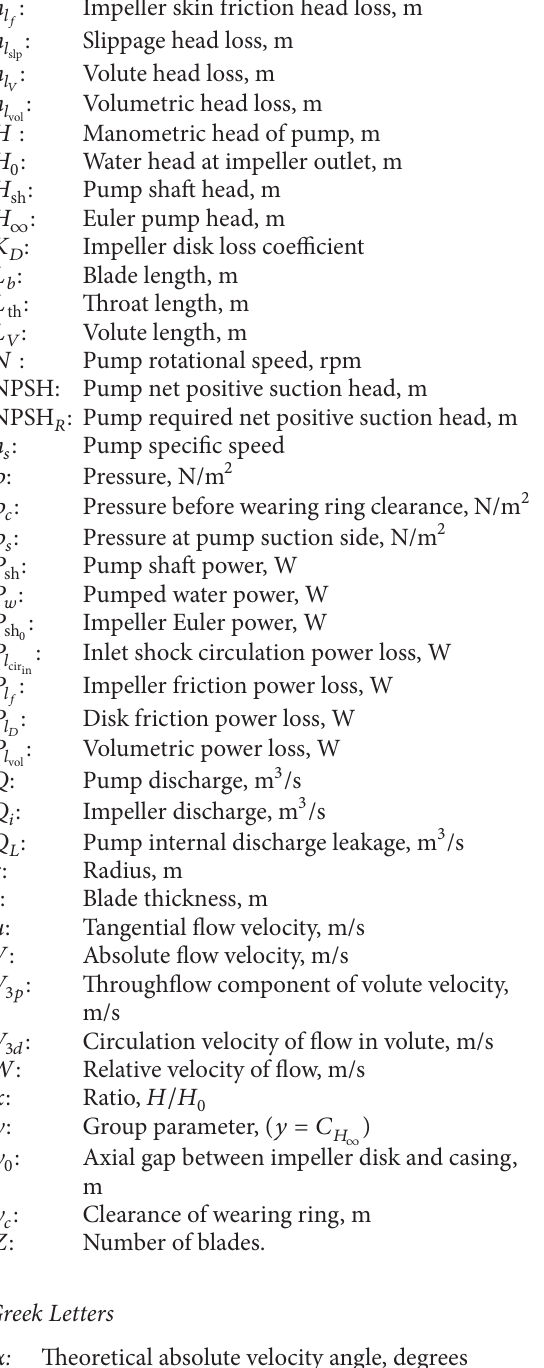
Manometric efficiency of pump